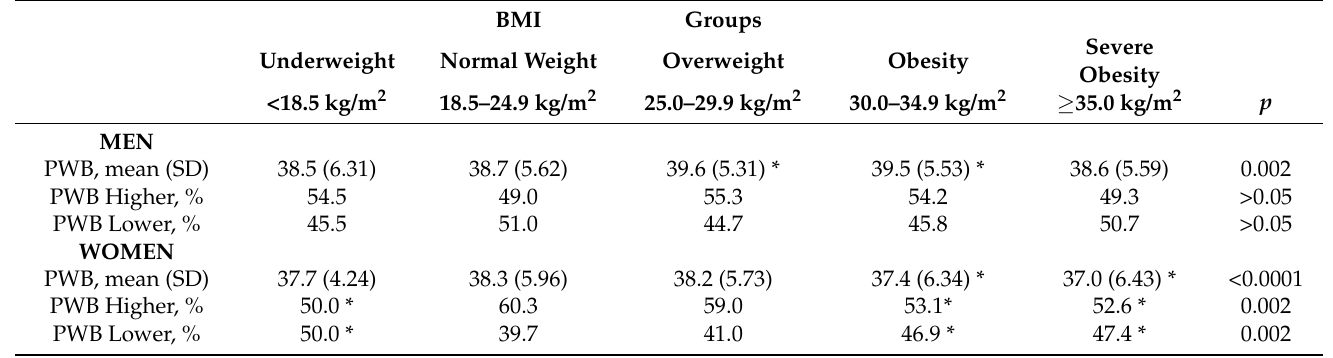
Table 2. Prevalence of higher and lower PWB in BMI groups according to gender.